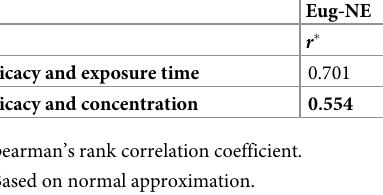
Table 1. Correlation between the concentration and exposure time of the scolicidal efficacy of Eug-NE and Eug against hydatid PCs. Eug-NE Efficacy and exposure time